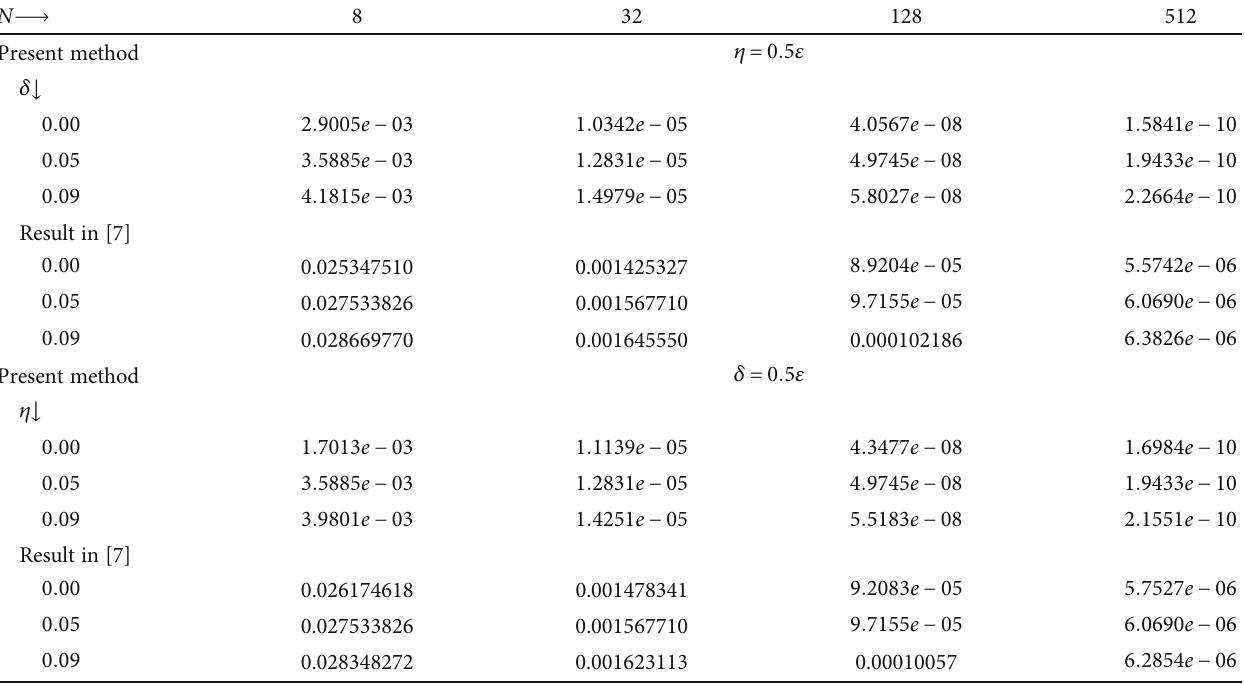
Table 3: Maximum absolute error of Example 6 for ε = 0 : 1